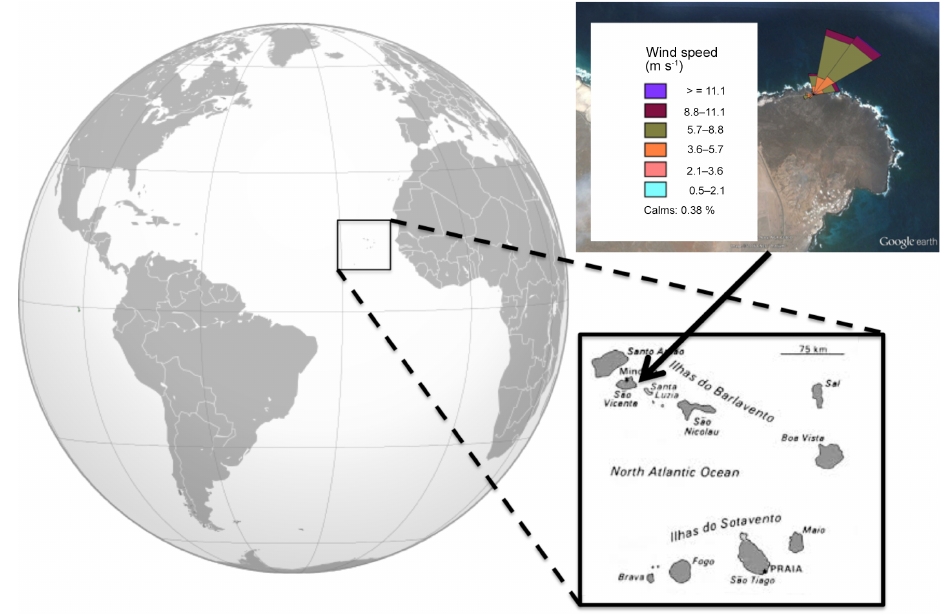
Figure 1. Cape Verde site location. Top right, image from Google Earth: V7.1.5.1557 (6 July 2016). São Vicente, Cape Verde, 16 ◦ 51 (cid:48) 59.60 (cid:48)(cid:48) N, 24 ◦ 52 (cid:48) 03.60 (cid:48)(cid:48) W; eye altitude 2.70km. Wind rose for the measurement period is coloured by wind